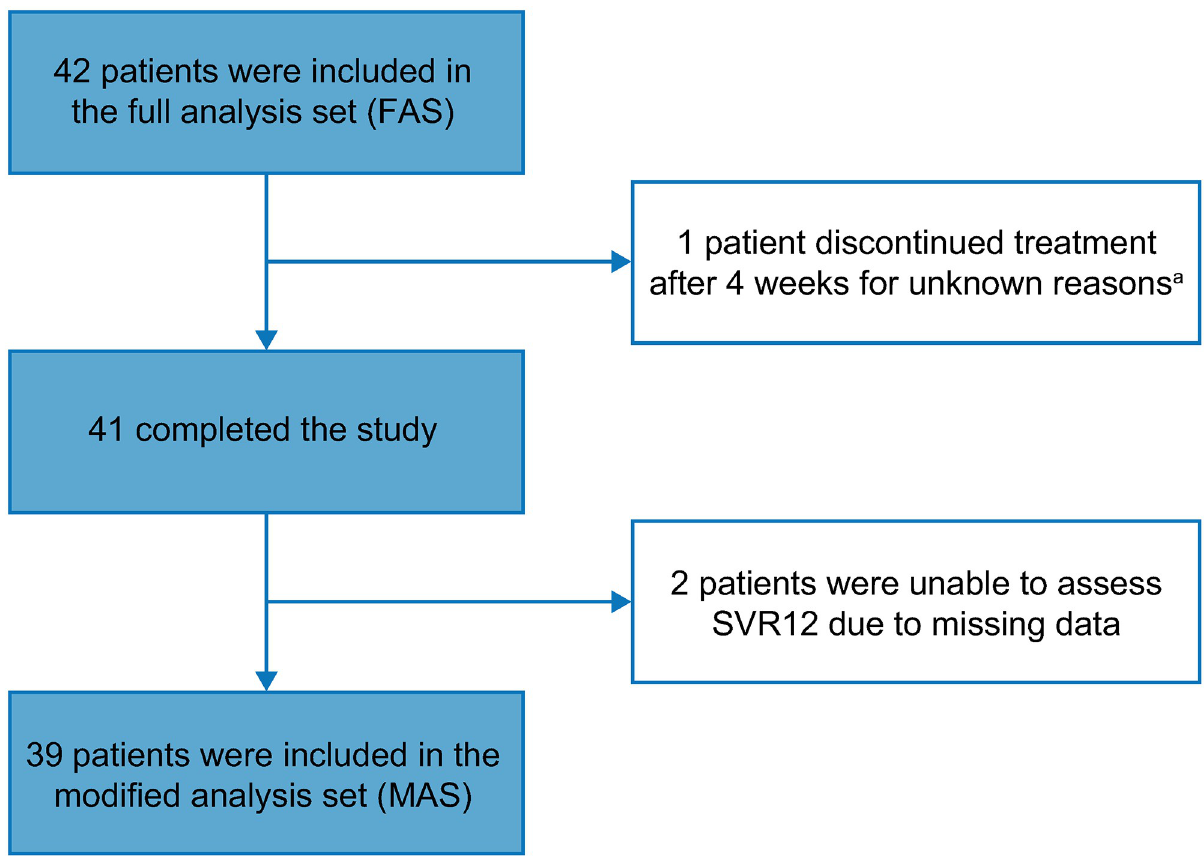
Fig 1. Patient disposition. a Although treatment was discontinued, this patient achieved SVR12. SVR12 sustained virologic response at posttreatment Week 12.